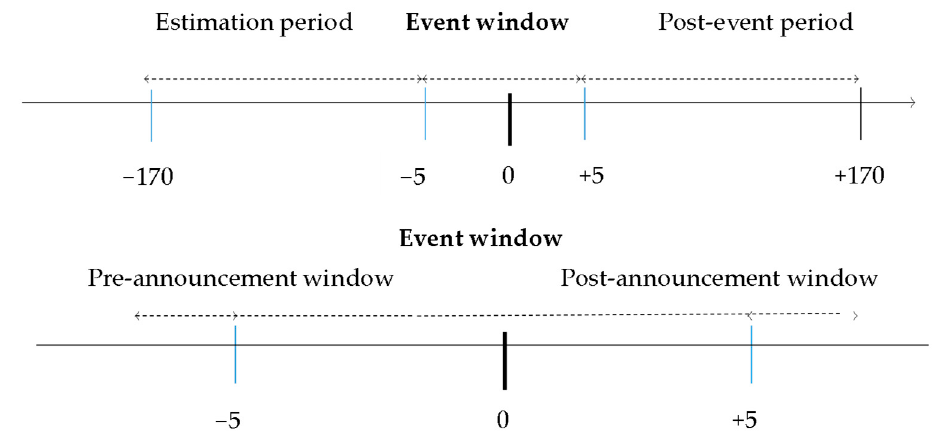
Figure 2. Event study window for cumulative abnormal trading volume.